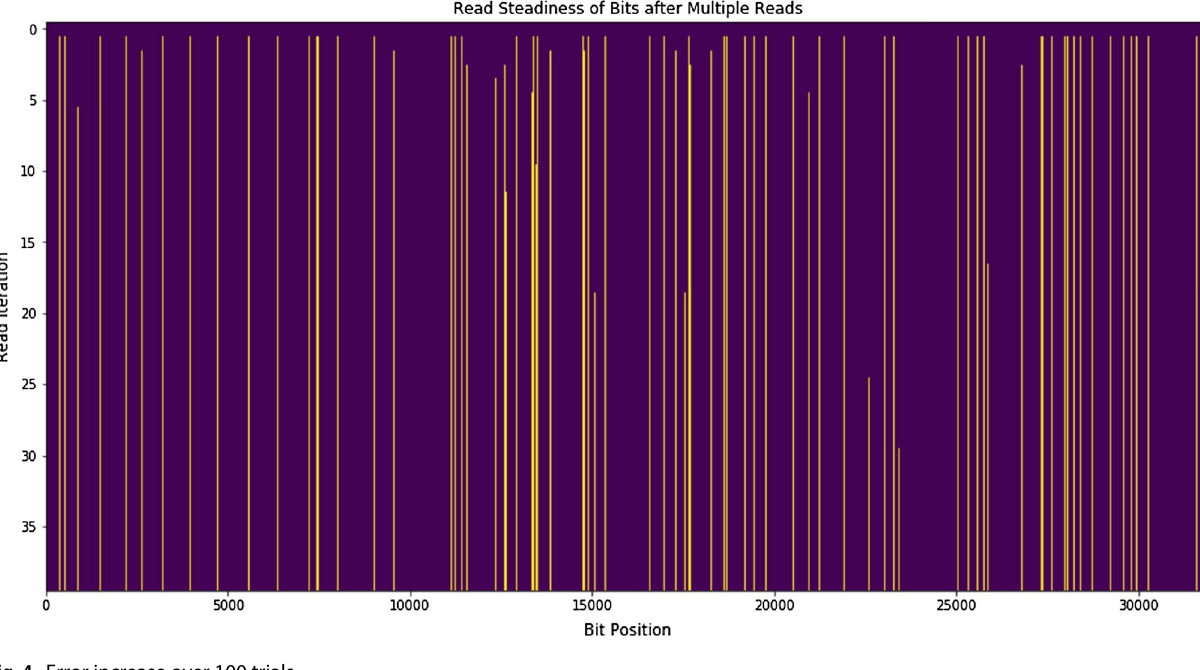
Fig. 4 Error increase over 100 trials